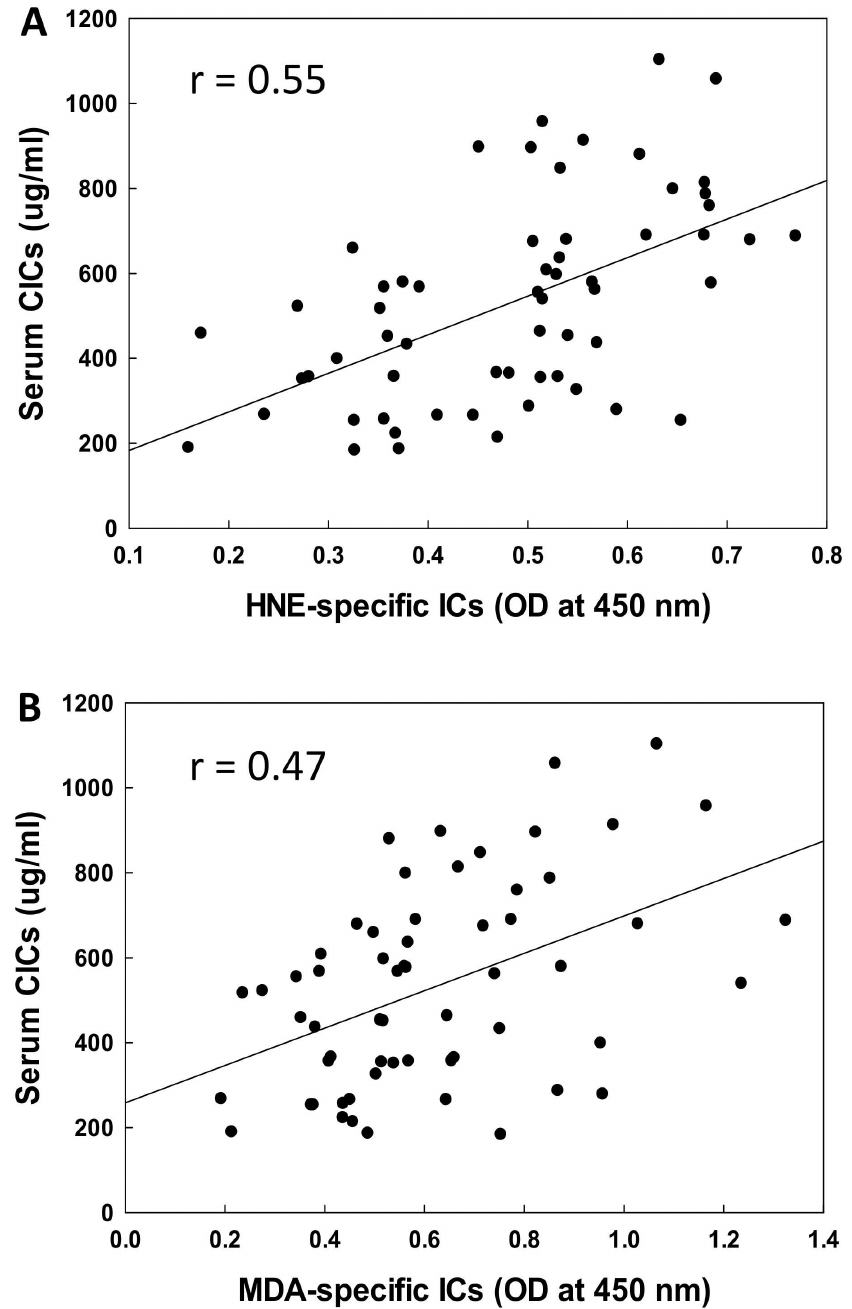
Fig 4. Correlation of serum HNE-specific ICs (A) or MDA-specific ICs (B) with serum CICs. The correlationwas establishedby calculating correlationcoefficients between HNE- or MDA-specific ICs and serum